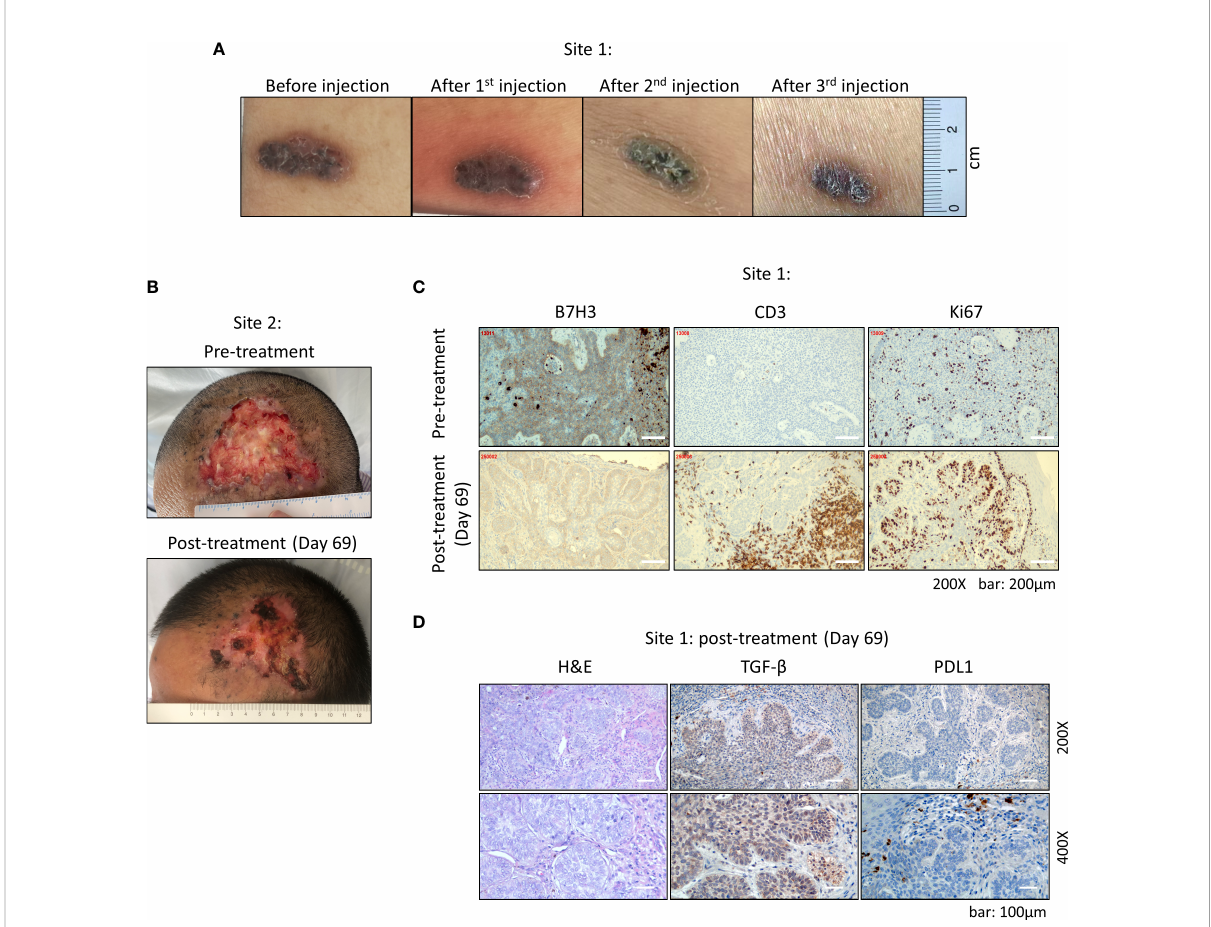
FIGURE 2 Clinical manifestation of multiple basal cell carcinoma after CAR-T cell therapy. (A) Abdominal tumor at site 1. After each injection, the tumor gradually shrank in size. (B) The large lesion of forehead tumor at site 2 became dry from original ulcer and bleeding. (C) Staining of B7-H3, CD3, and Ki67 of abdominal tumor at site 1 by immunohistochemistry (IHC). B7-H3 + cells showed sub-epithelial localization and were widely observed within the tumor tissue. CD3 staining showed an enrichment of T cells at the injection site within the tumor. (D) Expressions of TGF- b and PDL1 within the tumor tissue examined by IHC. All IHC slides were analyzed and scored by two individual pathologists